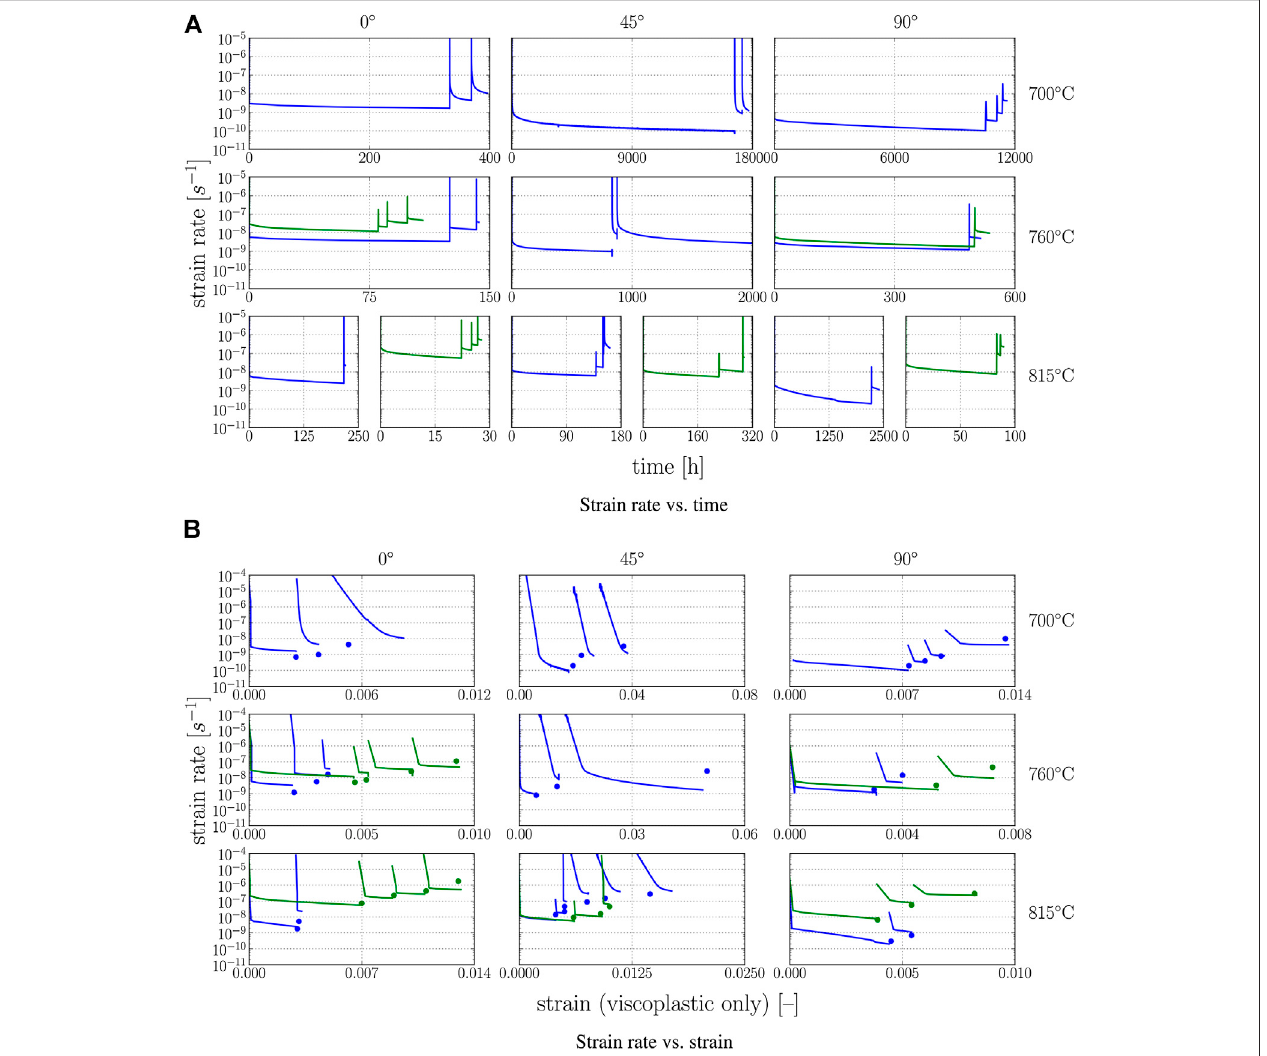
FIGURE9| Simulation results fordifferently oriented PSTcrystalsat thetemperaturesandstresslevels fromtheexperimentalresults inParthasarathyet al.(2000). Secondsimulationseries,thatis,thecreepstrainthataccumulatesduringthe1 sloadingperiodsissubtracted.Symbols:experimentallydetermined steady-statestrain rates at the corresponding strain, that is, at the end of primary creep stage. Solid lines: simulations.